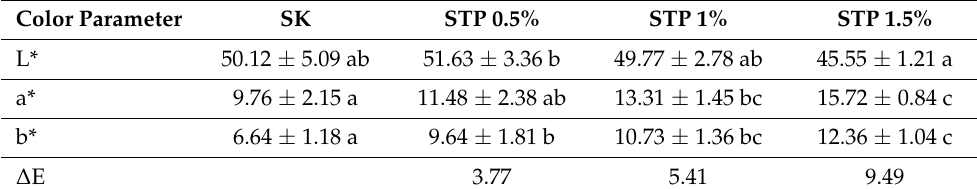
Table 5. CIE L*, a* and b* color parameters of dry fermented sausages. Color